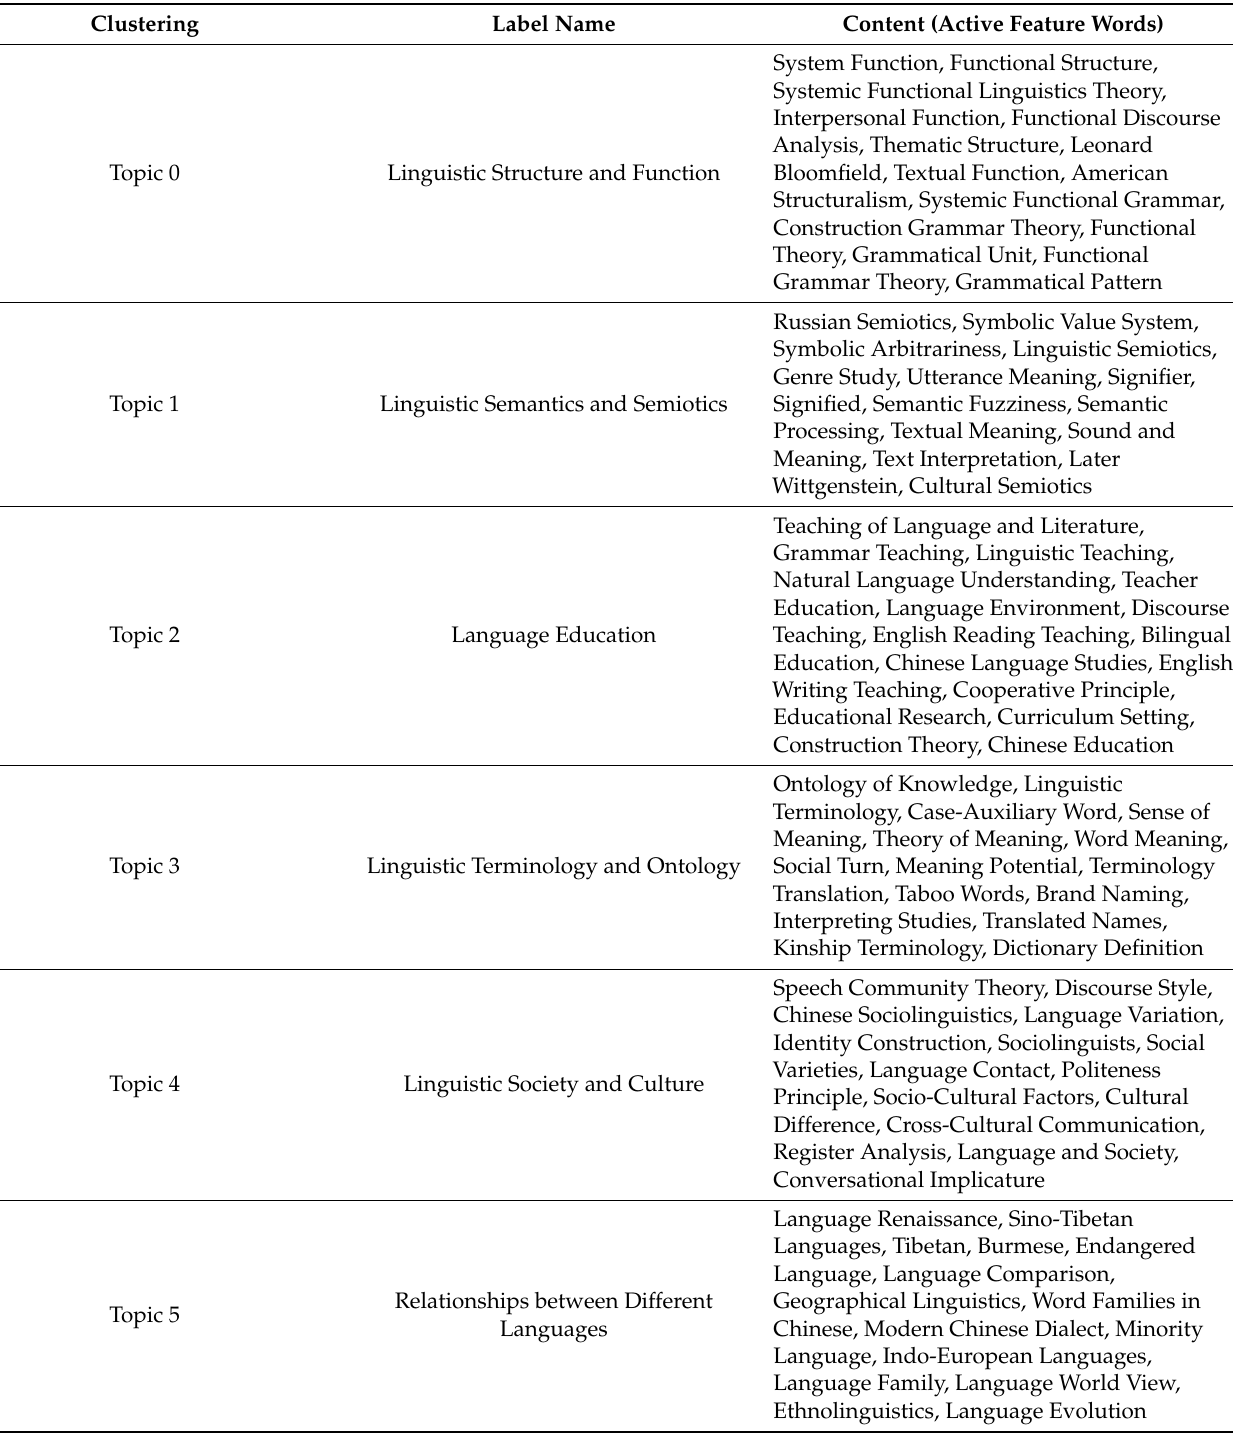
Table 2. Active feature words and topic labels of the optimal clustering